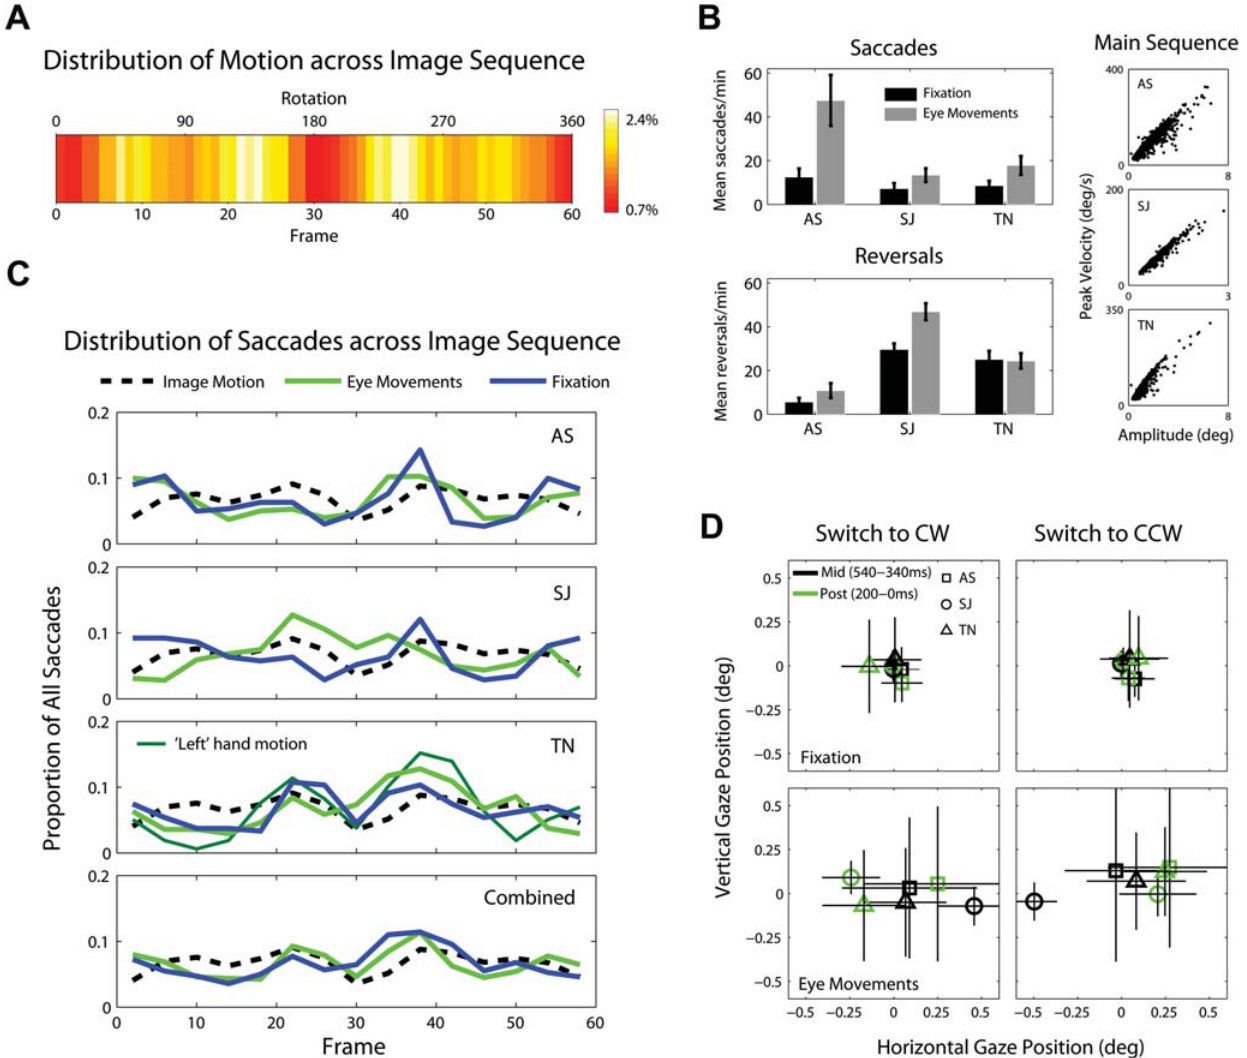
Figure 9. Eye movements and rotation speed. (A) For each individual dot making up the walker, we calculated the absolute horizontal distance traveled (in pixels) from frame to frame i.e. leftward and rightward motion are treated similarly. Combining the values for all thirteen dots at each frame, and dividing by the total motion in pixels over all frames, gives the proportion of image motion contained between any two frames in the rotation cycle. The colormap illustrates the distribution of image motion across the 60-frame sequence, with brighter values (white) indicating a greater proportion of image motion. (B) Mean saccades/min and reversals/min for each of the three observers, in the fixation (black) and eye movements encouraged (grey) conditions. Error bars represent standard deviations. To confirm that our saccade detection routines performed satisfactorily, we plotted saccade peak velocity against amplitude (i.e. the main sequence [32]). (C) For all saccades made in a particular condition, we calculated the proportion triggered during the presentation of individual frames of the rotation cycle, by noting the frame on screen during the starting sample of the saccade. The blue (fixation) and green (eye movements) lines illustrate this distribution, divided into fifteen equally-sized bins. The black line represents the distribution of image motion across the sequence. Note that the combined histogram data (row four) is not the average of individual datasets, but the pooled saccade data. (D) For each percept reversal, we compared the median fixation positions during two separate time windows prior to the button response: Mid-reversal (540ms-340ms prior to response), during which the reversal is estimated to have occurred, and Post-reversal (200ms-0ms prior to response). Each symbol corresponds to the average over all reversals for a particular observer. Horizontal and vertical lines represent the inter-quartile range along the respective axes. Note than unlike in Experiment 3, both transition types were monitored as normal in each trial. The plots separate the data for each transition type for comparison.